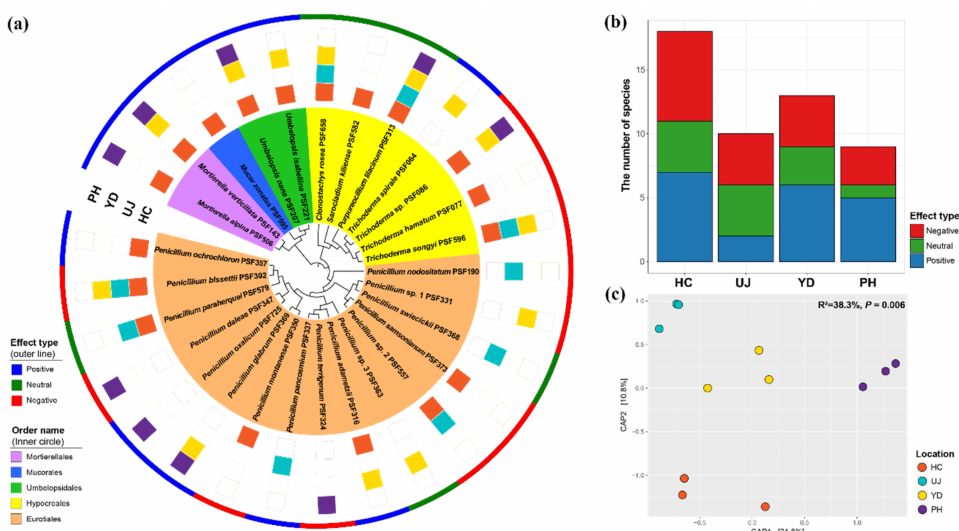
Figure 2. Patterns of occurrence and e ff ect type for microfungal species isolated from soil within PM fairy rings. ( a ) Phylogenetic tree with information for isolation location and e ff ect type on PM growth. The phylogenetic tree was constructed based on ITS sequences from the strain used for metabolite experiments. Colors in the box indicate the presence of the species in each location. Colors in the outer line indicate e ff ect type on PM growth. ( b ) Number of species isolated from four locations. ( c ) Constrained analysis of principal coordinates (CAP) plots for community structure based on binary Jaccard dissimilarity. CAP model constrained by sampling locations ( p = 0.006; 38.3% explanatory power). HC: Hongcheon site, UJ: Uljin site, YD: Yeongdeok site, PH: Pohang